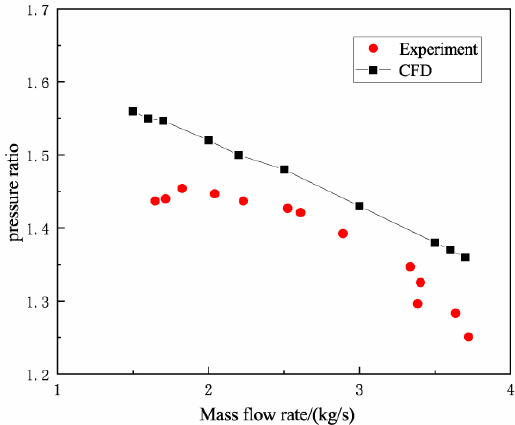
Figure 5. Numerical simulations validation.